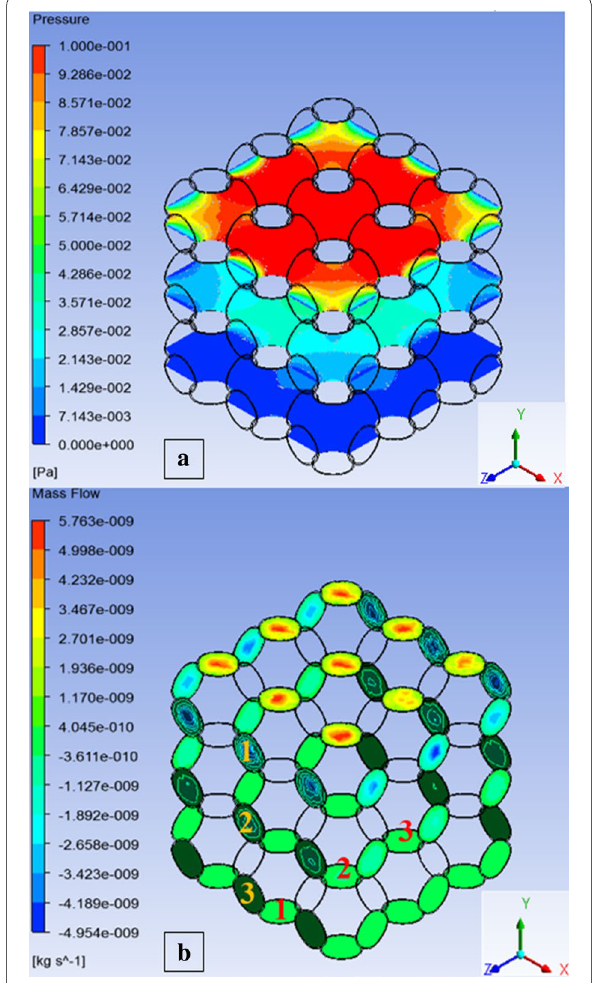
Figure 10 Locations of planes and outlets: a three planes, b bottom and side outlets